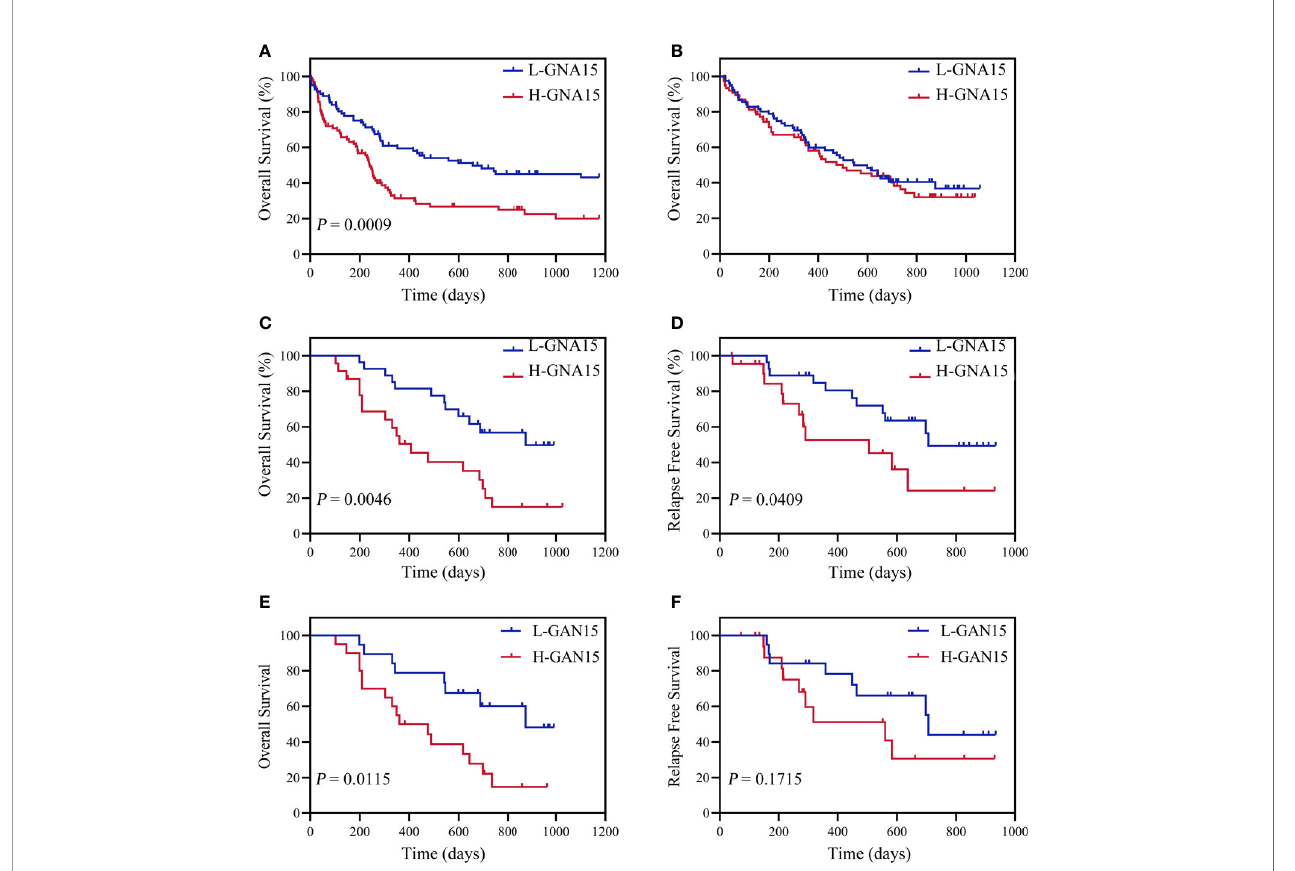
FIGURE 2 | Overall survival (OS) and relapse free survival (RFS) of adult subjects with AML according to GNA15 . (A) OS of 163 AML subjects with normal karyotype in GSE12417. (B) OS of 154 AML subjects in our cohort. (C, D) OS (C) and RFS (D) of 50 AML subjects with normal karyotype in our cohort. (E, F) OS (E) and RFS (F) of 39 FLT3-ITD - negative subjects in NK-AML cohort according to GNA15 . H- GNA15 , high GNA15 expression; L- GNA15 , low GNA15